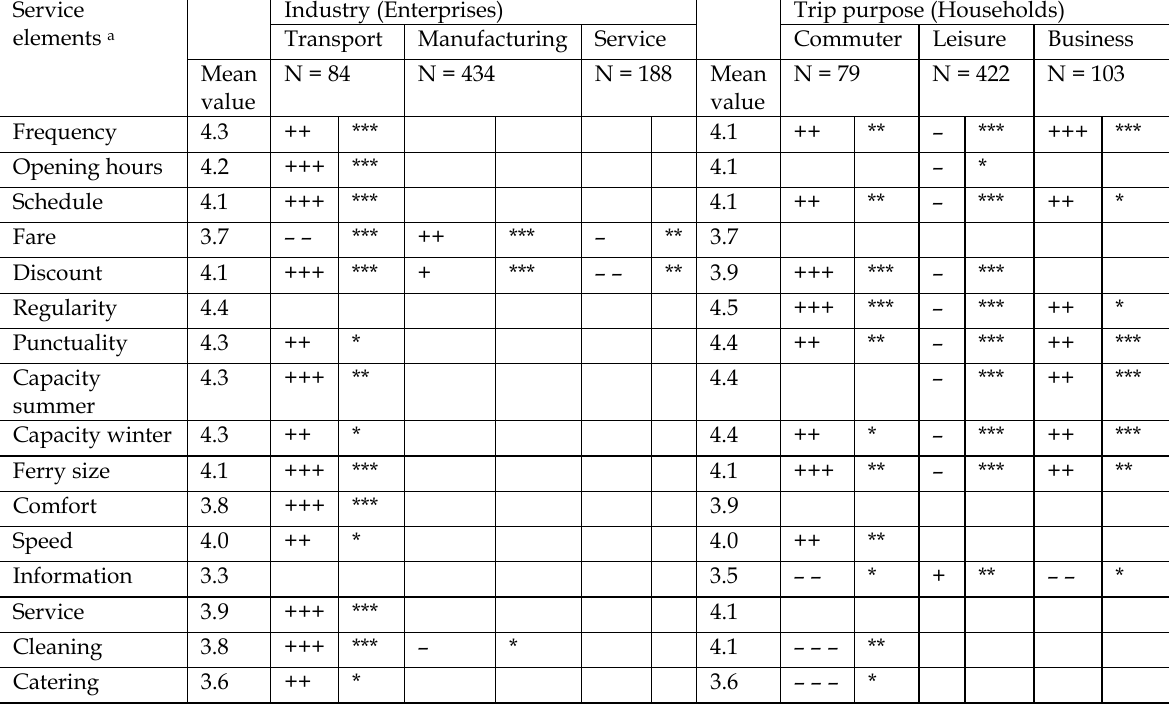
Table 4. Significant deviations in the assessment of importance for different groups of